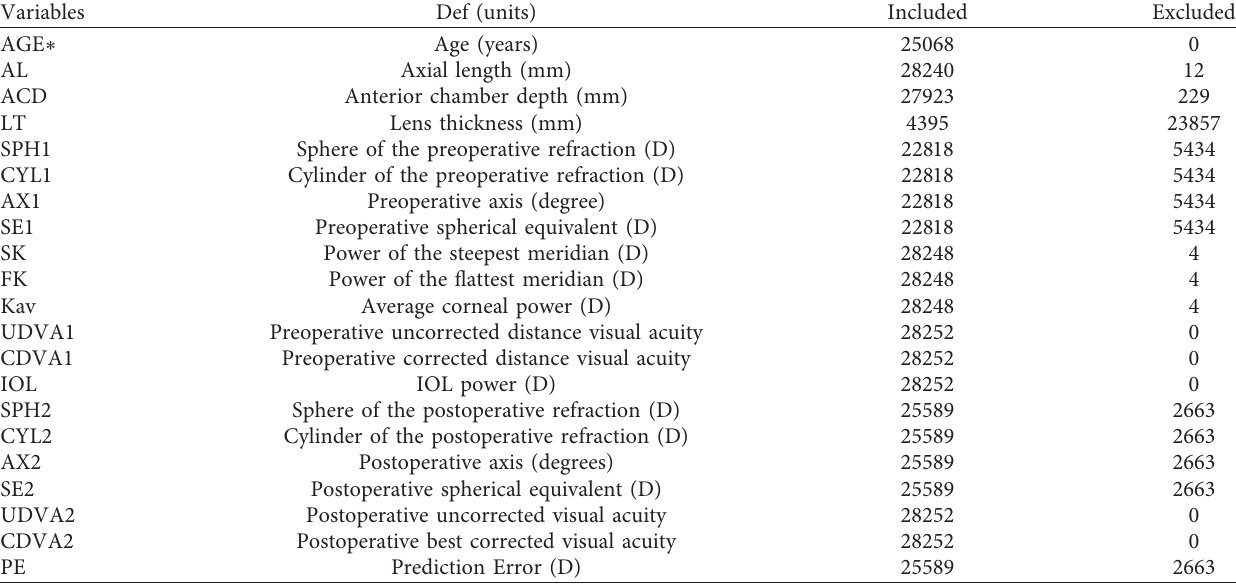
Table 1: Definition of the used variables, their units, and the amount of eyes included and excluded.